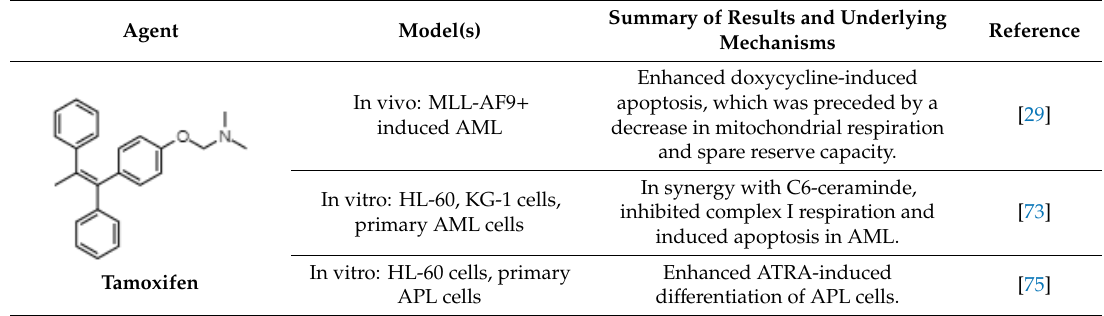
Table 1. AML and Specific Estrogen Receptor Modulators (SERMs).